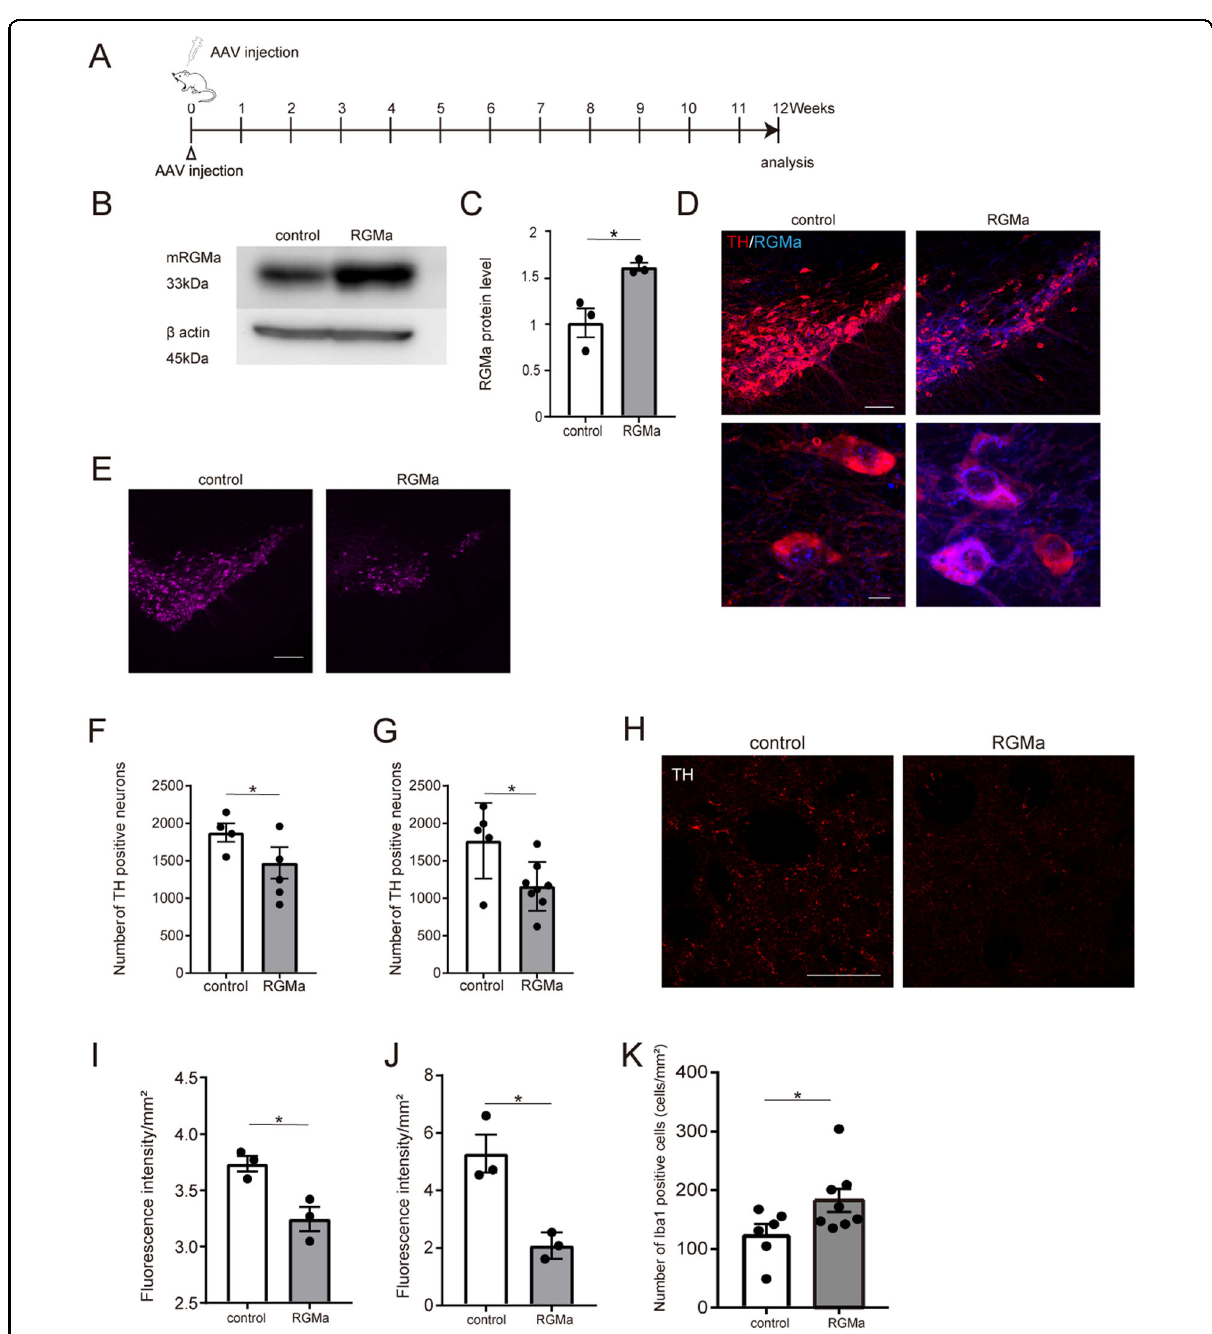
Fig. 4 AAV-mediated RGMa overexpression induces neuronal degeneration in the nigrostriatal pathway. A Schematic representation of the timeline of AAV injection in the SN. RGMa-encoding AAV was injected into the bilateral SN. GFP-encoding AAV was used as a control. B Western blot analysis showing the increased expression of RGMa protein in the SN. Beta-actin was used as the loading control. C Quantitative data for B . RGMa protein expression was signi fi cantly higher in mice injected with RGMa-encoding AAV compared to GFP-injected control animals. n = 3. * P < 0.05, Student ’ s t test. D Coimmunostaining for RGMa and TH in the SN of mice injected 12 weeks after AAV injection. Low magni fi cation (top): Scale bar, 200 μ m. High magni fi cation (bottom); scale bar, 10 μ m. E Immuno fl uorescent staining for TH in the SN of mice injected 12 weeks after AAV injection. Scale bar, 200 μ m. F , G Stereology counts of TH-positive neurons in the SN of mice 8 weeks ( F ) and 12 weeks ( G ) after AAV injection. n = 4 – 5 ( F ), n = 5 – 8 ( G ). * P < 0.05, Student ’ s t test. H Immuno fl uorescent staining for TH in the striatum of mice injected 12 weeks after AAV injection. Scale bar, 50 μ m. I , J Relative TH fl uorescence intensities were measured in the striatum at 8 weeks ( I ) and 12 weeks ( J ) after AAV injection using the ImageJ software. n = 3, each group. * P < 0.05, Student ’ s t test. K Stereology counts of Iba1-positive neurons in the SN of mice 12 weeks after AAV injection. n = 6 – 9. * P < 0.05, Student ’ s t test.